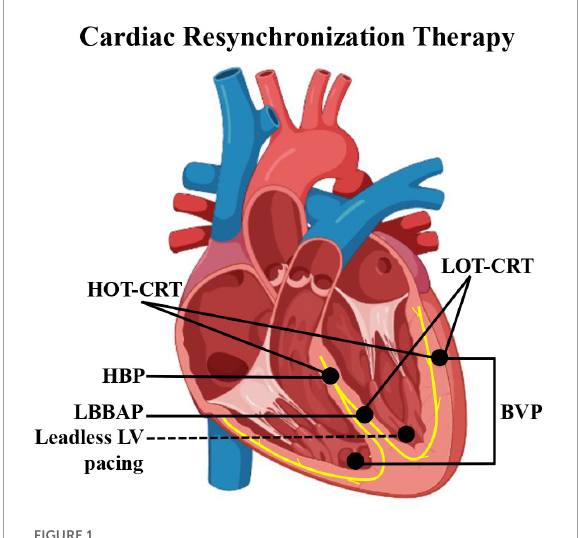
FIGURE1 Schematic diagram of pacing electrode positions of different CRT modalities. BVP, biventricular pacing; CRT, cardiac resynchronization therapy; HBP, His bundle pacing; HOT-CRT, His-optimized CRT; LBBAP, left bundle branch area pacing; LOT-CRT, LBBAP-optimized